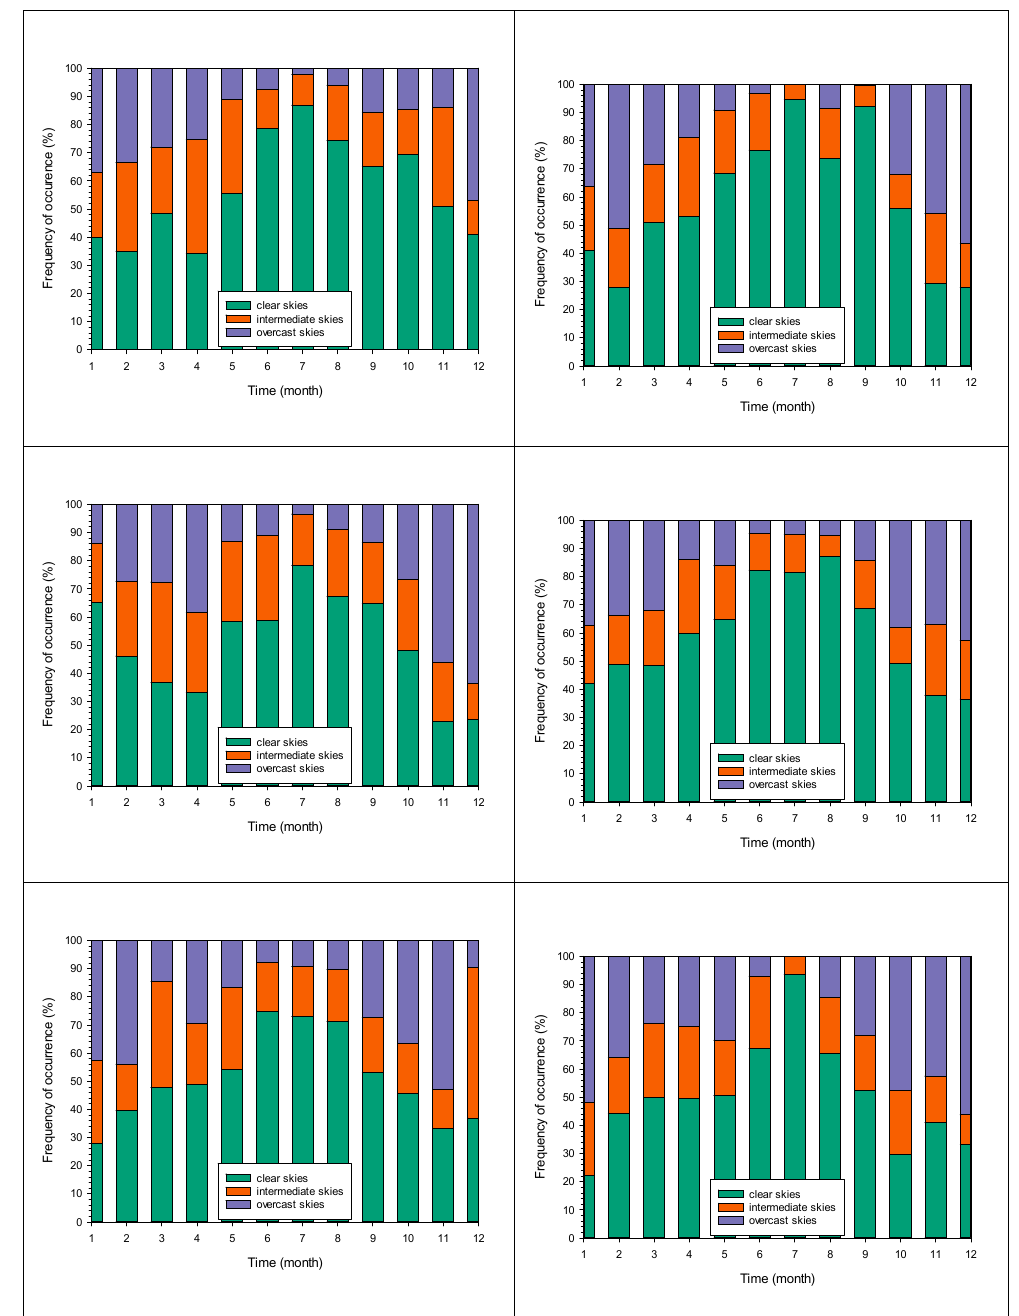
Figure 2. Bar charts showing the frequency of occurrence (in %) of the sky conditions over a complete year in climatic zone A: first raw, Irakleio (left), Kalamata (right); climatic zone B: second raw, Agrinio (left), Lesvos (right); climatic zone C: third raw, Alexandroupoli (left), Tripoli (right); climatic zone D: fourth raw: Kastoria (left), Serres (right). For information about the four climatic zones in Greece, see Section 2.2.